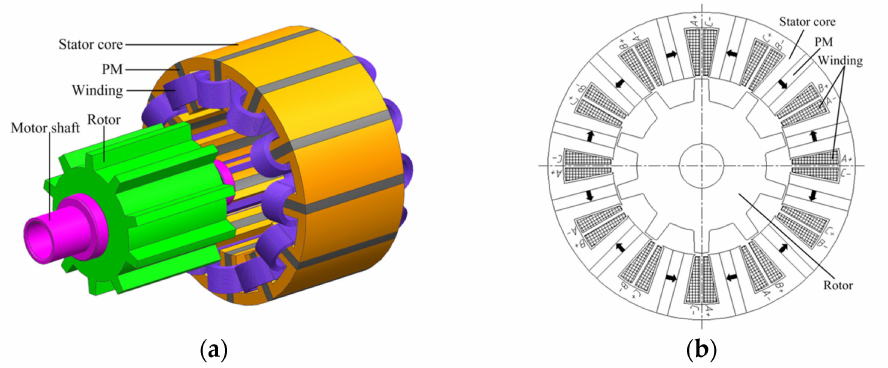
Figure 2. Structure of a 3-phase, 12-stator-tooth, 10-rotor-pole FSPM. ( a ) Schematic diagram; ( b ) as- sembly